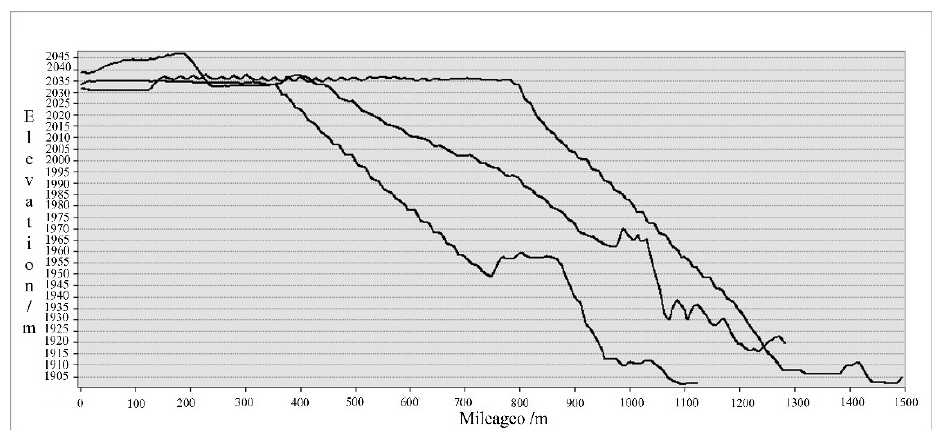
Figure 4. Sectional view.